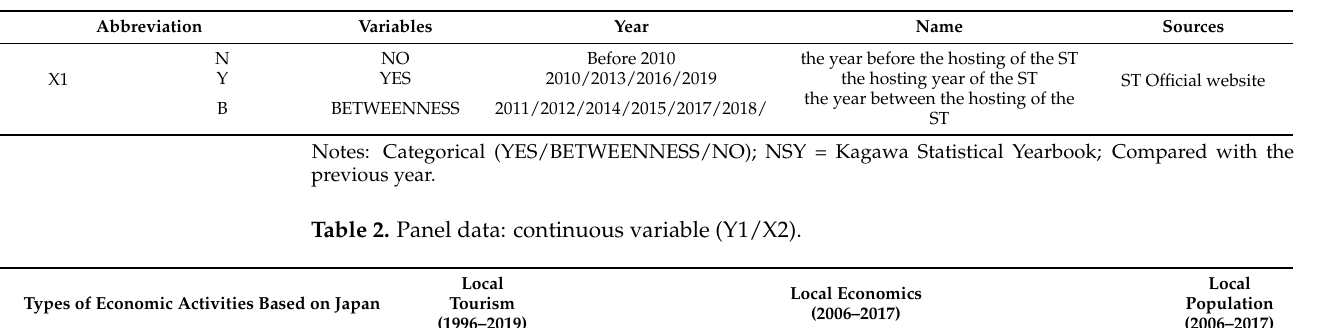
Table 1. Categorical variables (X1).